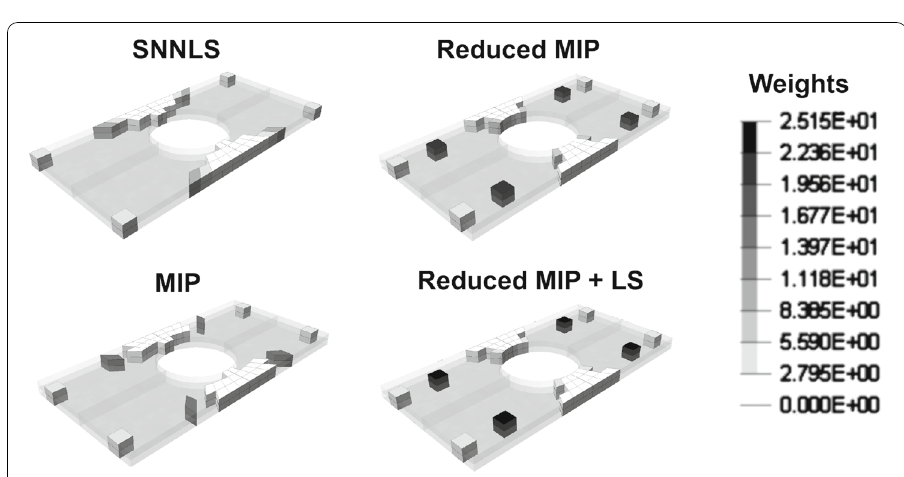
Fig. 14 Element selection for the hyper-reduced integration schemes of size ten computed with the different